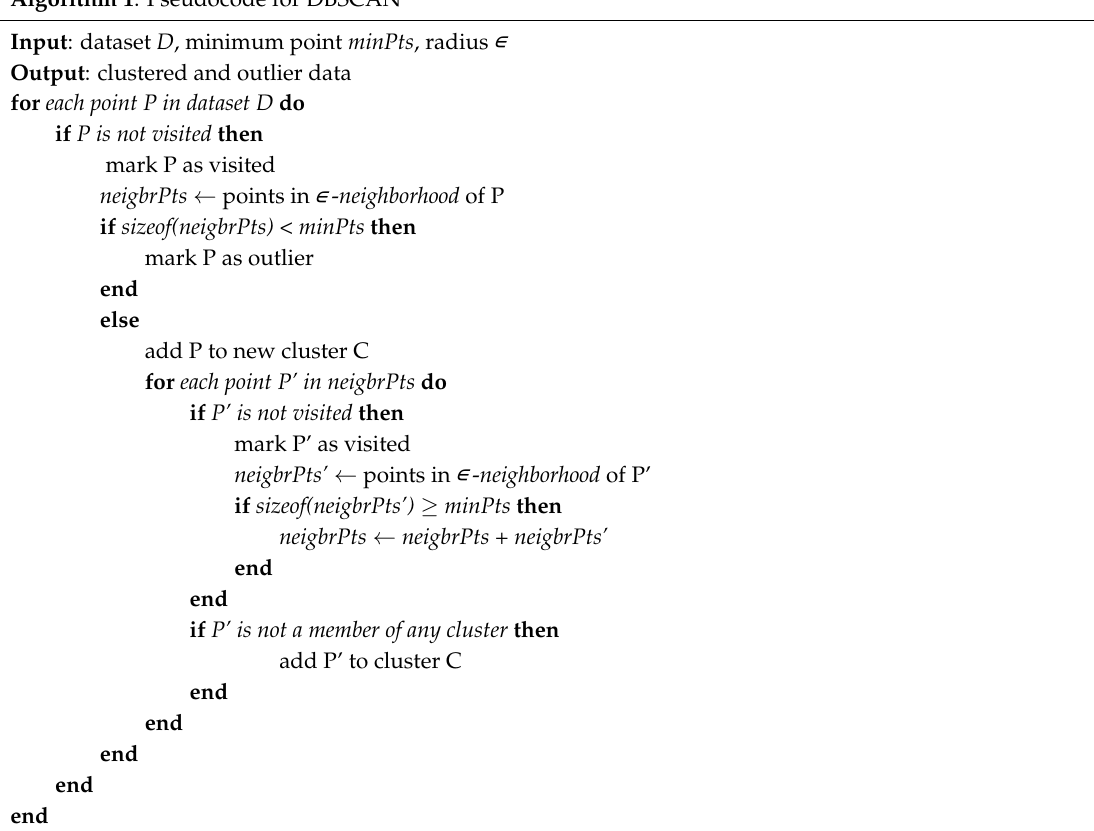
Algorithm 1 . Pseudocode for DBSCAN